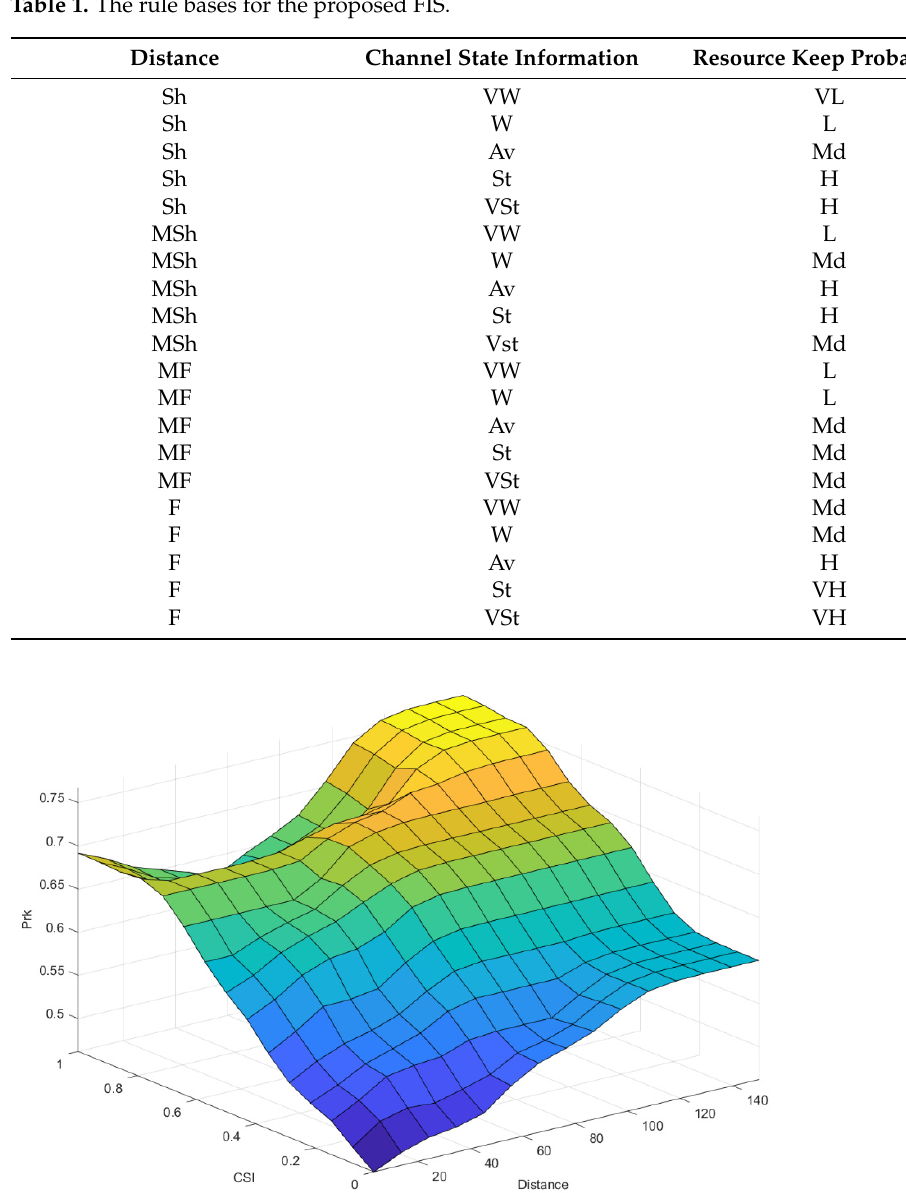
Figure 7. The relationships of inputs and output in the proposed FIS with a 3D diagram.